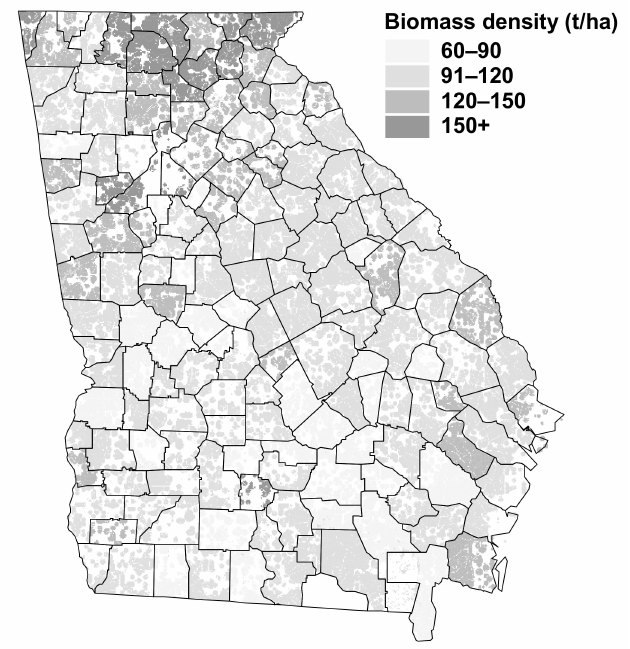
Figure 3. Biomass density (t/ha) on county level of resolution in